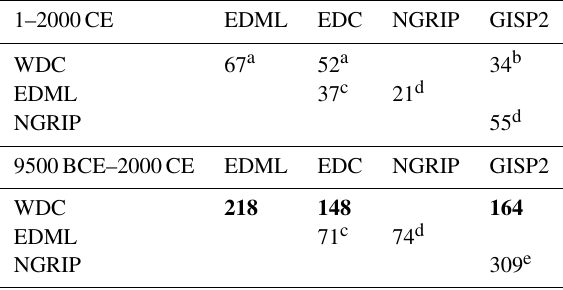
Table 2. Number of volcanic tie pints identified between different deep ice